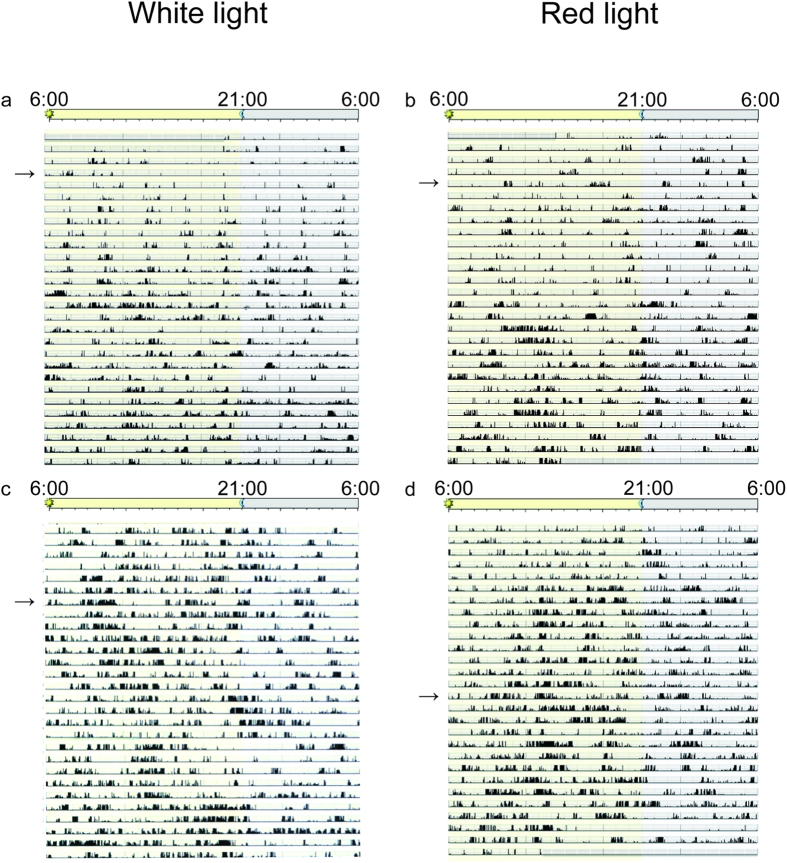
Actograms of rest-activity in representative infants who were exposed to white LED light (a,c) or red LED light (b,d) during night in an LD cycle. Dark bars represent activity; the same activity scale is used in each plot. The time of day is shown at the top. Actograms from a representative infant exposed to either white LED light (a) or red LED light (b) at around 35 WGA. Activity bouts occur every 2–3 hours associated with nursing care such as feeding and diaper changes. The arrows in the plots depict the date of 35 weeks of gestational age (WGA). Actograms from a representative infant exposed to either white LED light (c) or red LED light (d) at around 38 WGA. The arrows in the plots depict the date of 38 WGA. Note that more active patterns during daytime in both groups of infants are apparent after around 38 WGA in both groups of infants regardless of the wavelength of LED light used.